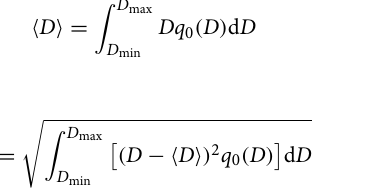
DLS h ) as determined using HAADF-STEM and DLS, respectively.